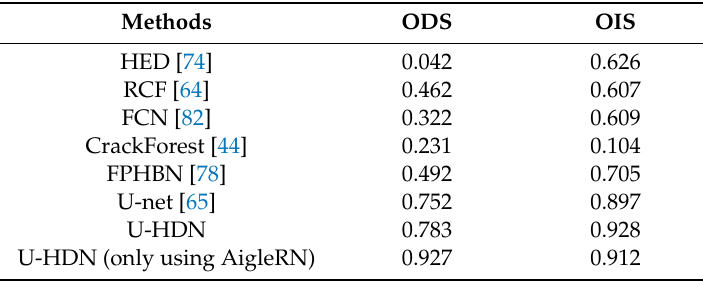
Table 7. The ODS, and OIS of comparison methods on AEL.